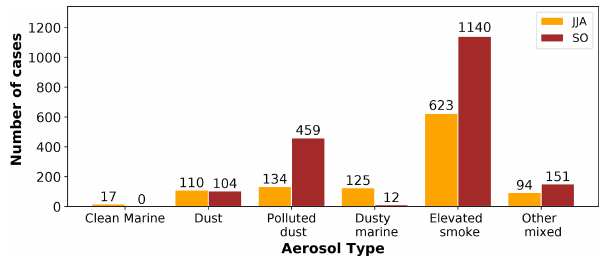
Figure 1. Number of profiles for each aerosol type found in the aerosol layers fulfilling the selection criteria (Sect. 2.3) during the months June–July–August (JJA) and September–October (SO) dur- ing the period 2007–2010. All aerosol types, except “Other mixed”, have the original name given by the CALIOP V4 algorithm. Other mixed refers to situations with more than one aerosol layer, where at least one of the layers is not defined as elevated smoke. Our smoke cases correspond to elevated smoke whereas our non-smoke cases contain the rest of the aerosol